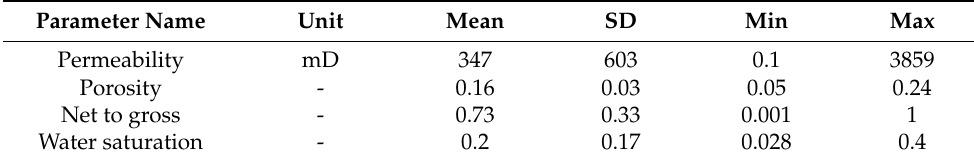
Table 1. The summary of basic petrophysical properties of the analyzed